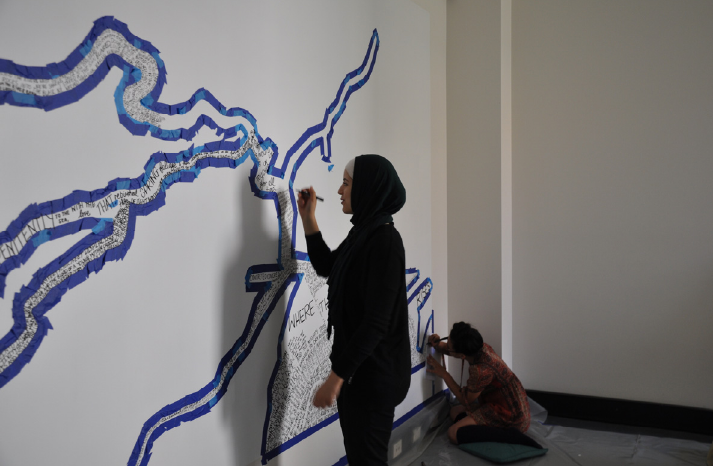
Figure 3. Installation still Where the River Rises: A River of Words. (Photo courtesy of